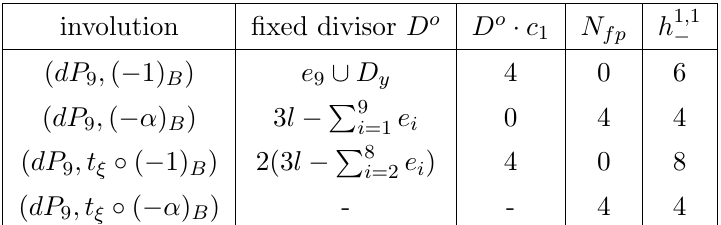
Table 1 . Some Z 2 involutions of dP 9 surfaces, the (cid:12)xed divisor D o